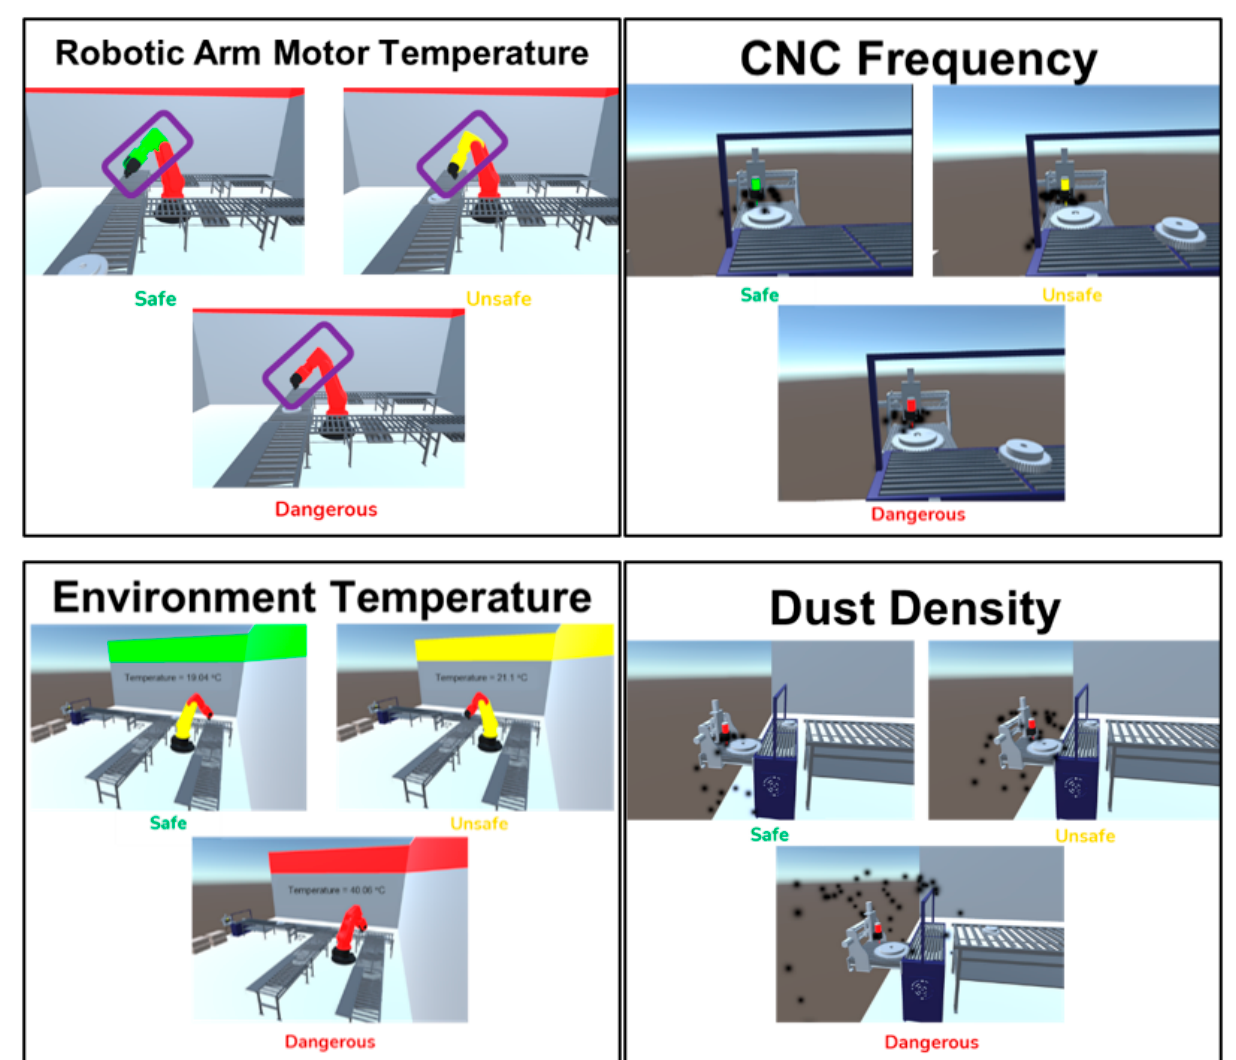
Figure 10. Some screenshot examples of the visualization of all elements in the system.